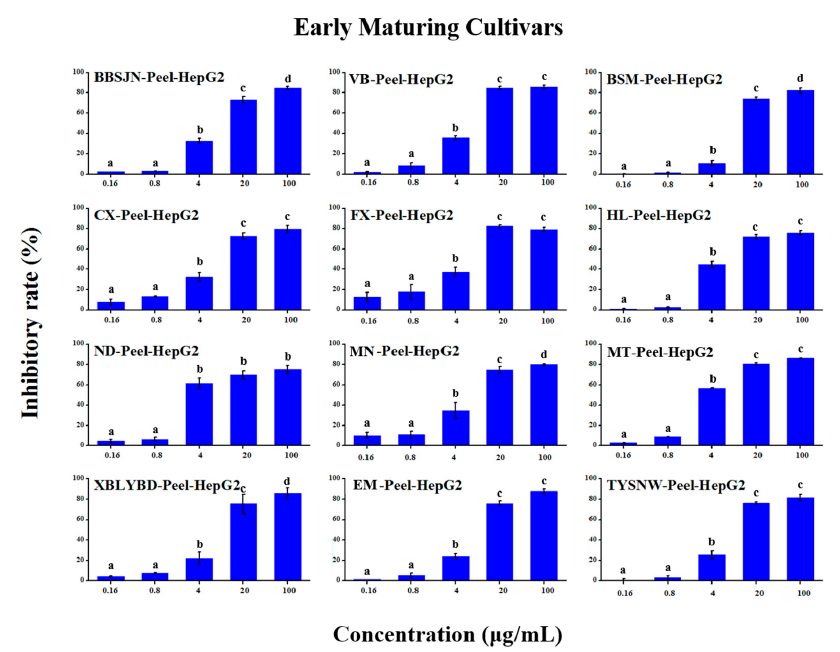
Figure 3. HepG2 growth inhibition e ff ect of peel extracts from early maturing cultivars. The names of apple cultivars were showed as abbreviations: VB for ‘Vista Bella’, MT for ‘Mato’, EM for ‘Early McIntosh’, TYSYW for ‘Tianyisayewa’, CX for ‘Chunxiang’, FX for ‘Faxian’, MN for ‘Matsumoto Nishiki’, BBSJN for ‘Babusijinuo’, XBLYBD for ‘Xiboliyabaidian’, BSM for ‘Basimei’, HL for ‘Honglu’, ND for ‘Nuoda’. Di ff erent lowercase letters above the bars indicated significant di ff erences at the 0.05 probability level by Tukey test.